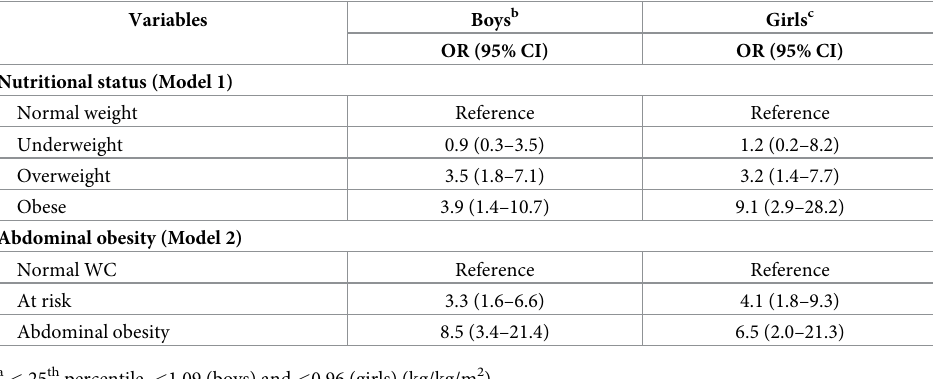
Table 4. Adjusted associations of low RHGS a (kg/kg/m 2 ) with nutritional status (model 1) and abdominal obesity (model 2) among Chilean adolescents, stratified by sex.